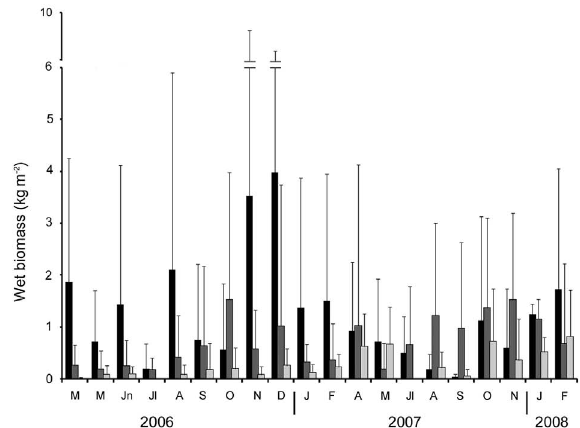
Fig. 6. – Monthly variation of the wet biomass of Gracilaria gracilis (black), other macroalgae (dark gray) and epiphytes of G. gracilis (light grey). Standard error bars are